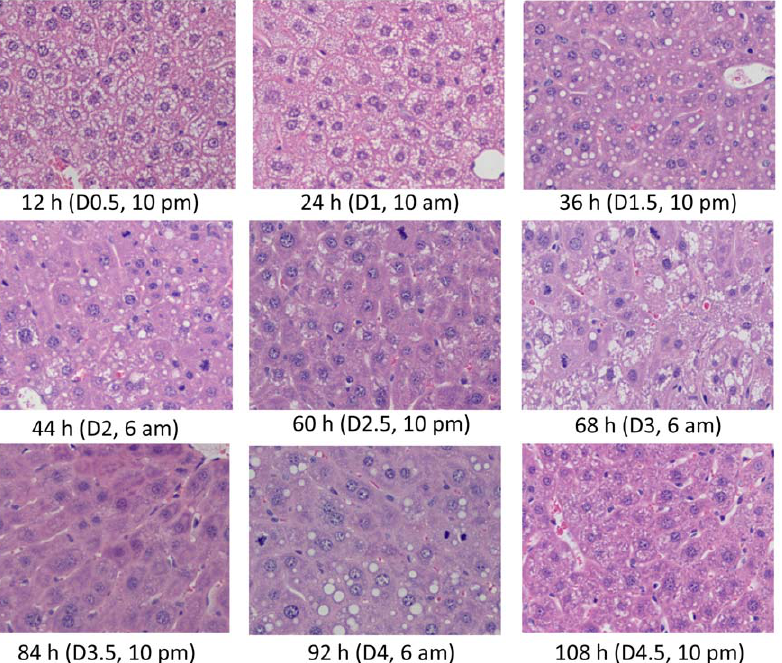
Figure 7. Histological analysis of regenerating livers. Livers were isolated at the indicated time points from mice that underwent partial hepatectomy. Formalin-fixed and paraffin-embedded liver sections were prepared and subjected to hematoxylin and eosin staining (400 6 original magnification).